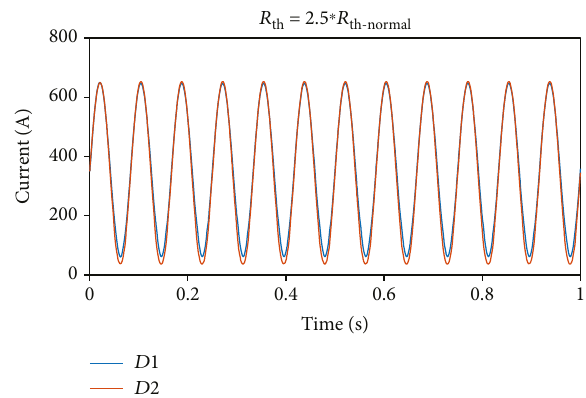
Figure 3: Currents of parallel-connected power modules ( D 1 aged to 2 5 ∗ R th − normal ).